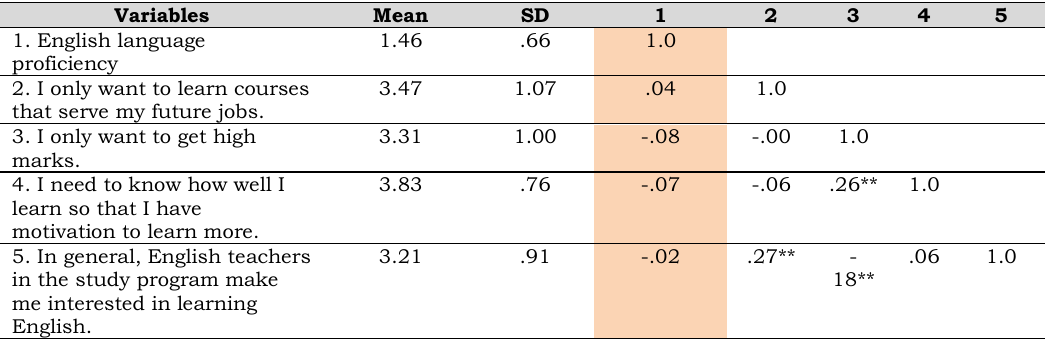
Table 4: Correlation Matrix (observed variables) of students’ EP and